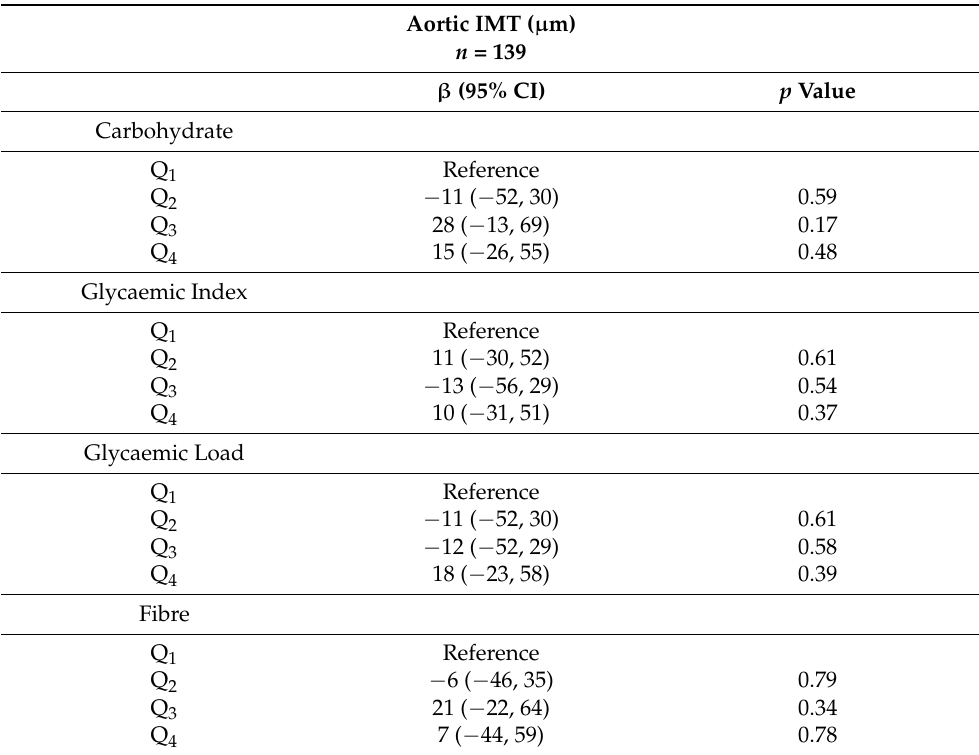
Figure 1. Correlation between maternal fibre (g/d) intake and offspring maximum aortic intima- medial thickness. Table 2. Associations between maternal carbohydrate intake, both quantity and quality, with newborn aortic intima-medial thickness